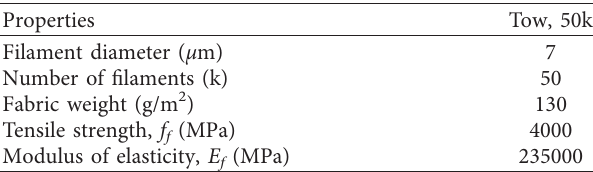
Figure 1: Carbon textile reinforcement unidirection 50 k. Table 1: Properties of carbon textile fibres supplied by the manufacturer.